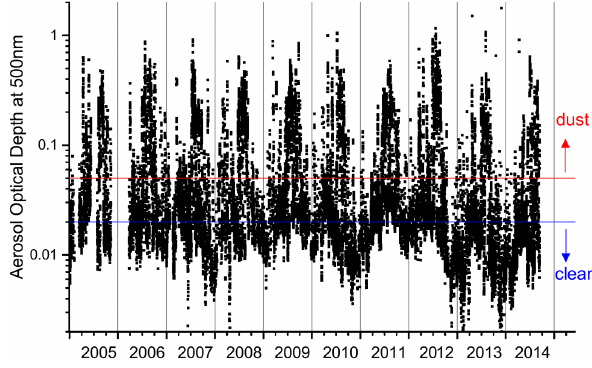
Figure B3. Time series of the AERONET aerosol optical depth at 500nm reported for Izaña (2005–2012: level 2.0; 2013 and 2014: level